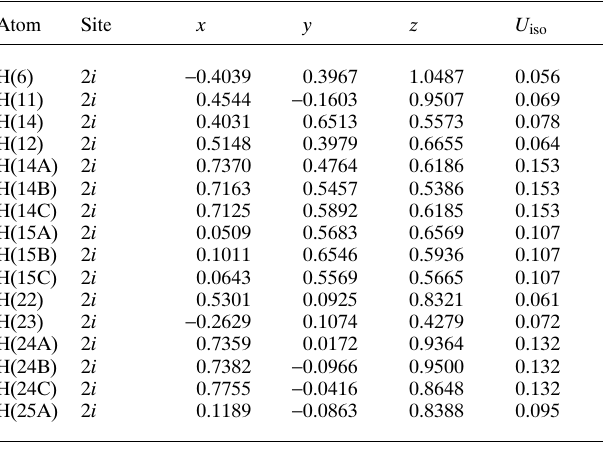
Table 2. Atomic coordinates and displacement parameters (in Å 2 )